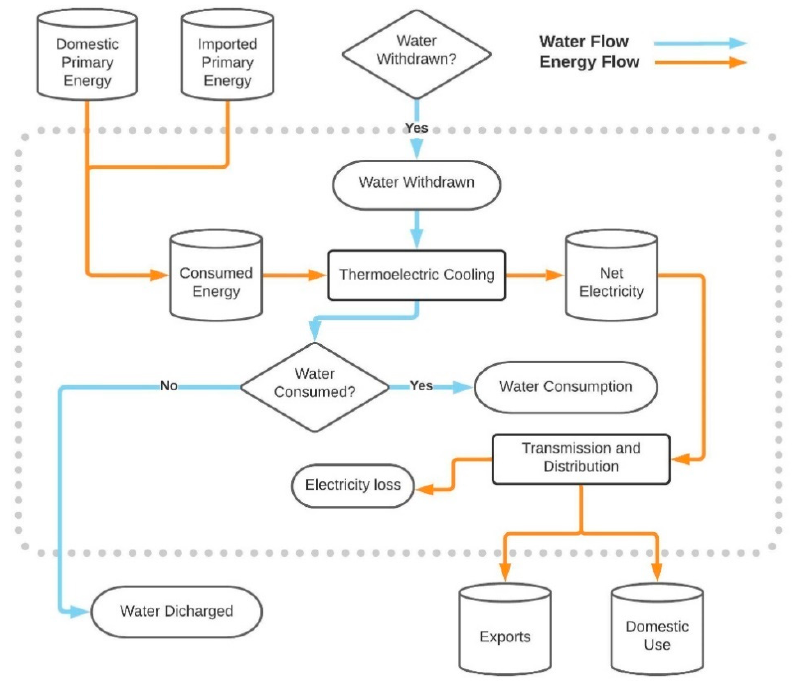
Figure 1. Model framework for water–energy nexus of electricity generation at a power plant scale, as illustrated within the system boundary (i.e., grey dotted line). Water use (i.e., blue line) and energy use (i.e., orange line) enter the system boundary to be used for net electricity production and exit after thermoelectric cooling, transmission, and distribution.